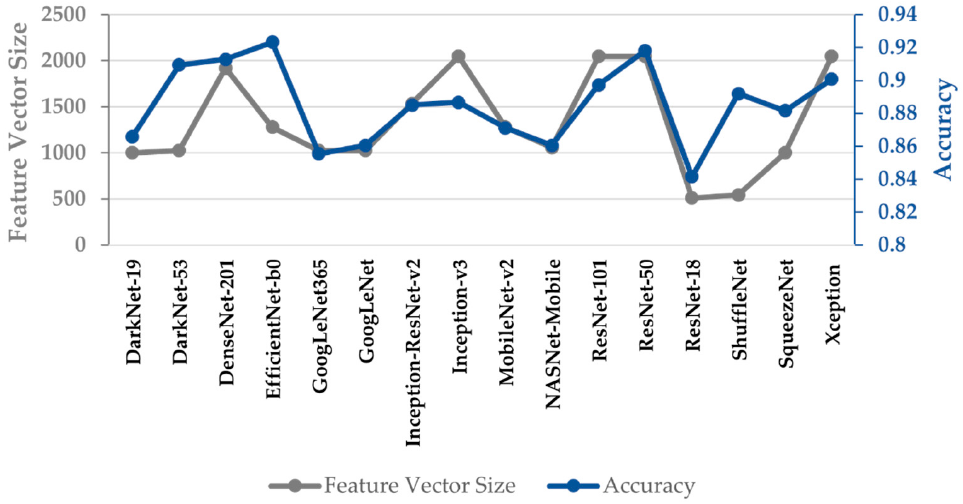
Figure 5. Performance of the SVM classifier trained with full deep features of pre-trained models.